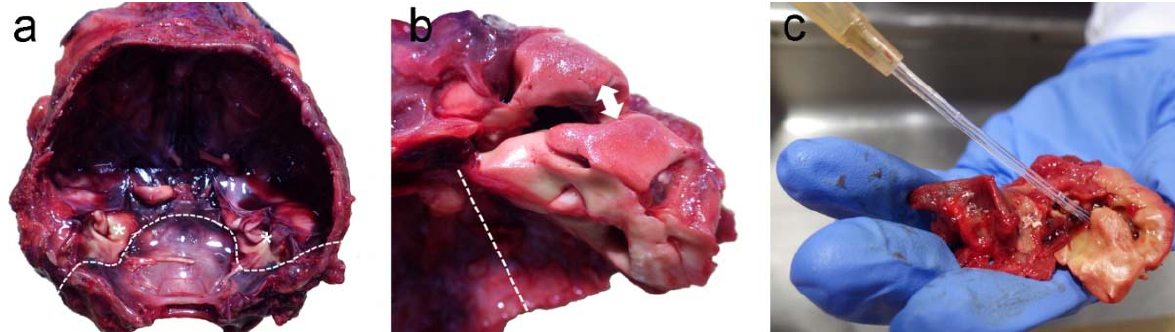
Figure 1. ( a ) Skull after the extraction of the brain with the location of the ears (asterisks). The dotted line indicates the position of the occipitomastoid suture, where the chisel is placed to remove the occipital bone. ( b ) Separation of the periotic from the tympanic bone by first placing the chisel in the location highlighted with the double arrow, and collection of the periotic bone by sectioning the squamosal bone through the dotted line. ( c ) The final step of the perilymphatic perfusion through the oval window with fixative, after extracting the stapes and perforating the round and oval window membranes with a small needle.